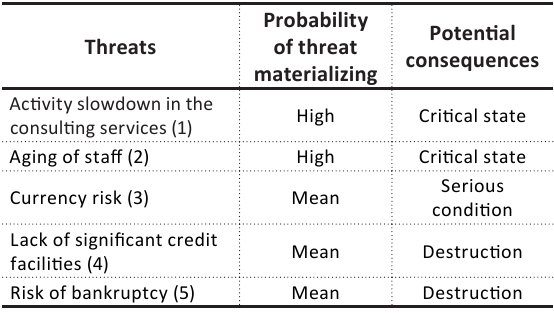
Table 5. Sigma Software threat matrix Threats